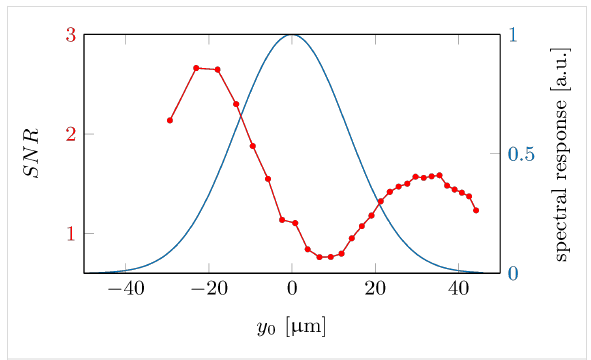
Figure 9: Comparison of the measured (red dots) and simulated (blue lines) data for the detection signal, the normalized autocorrelation function and the Fourier transform. The outcoupling position has been fixed at y 0 = 32.6 μ m ( Δ = 2 π × 2.03 MHz).